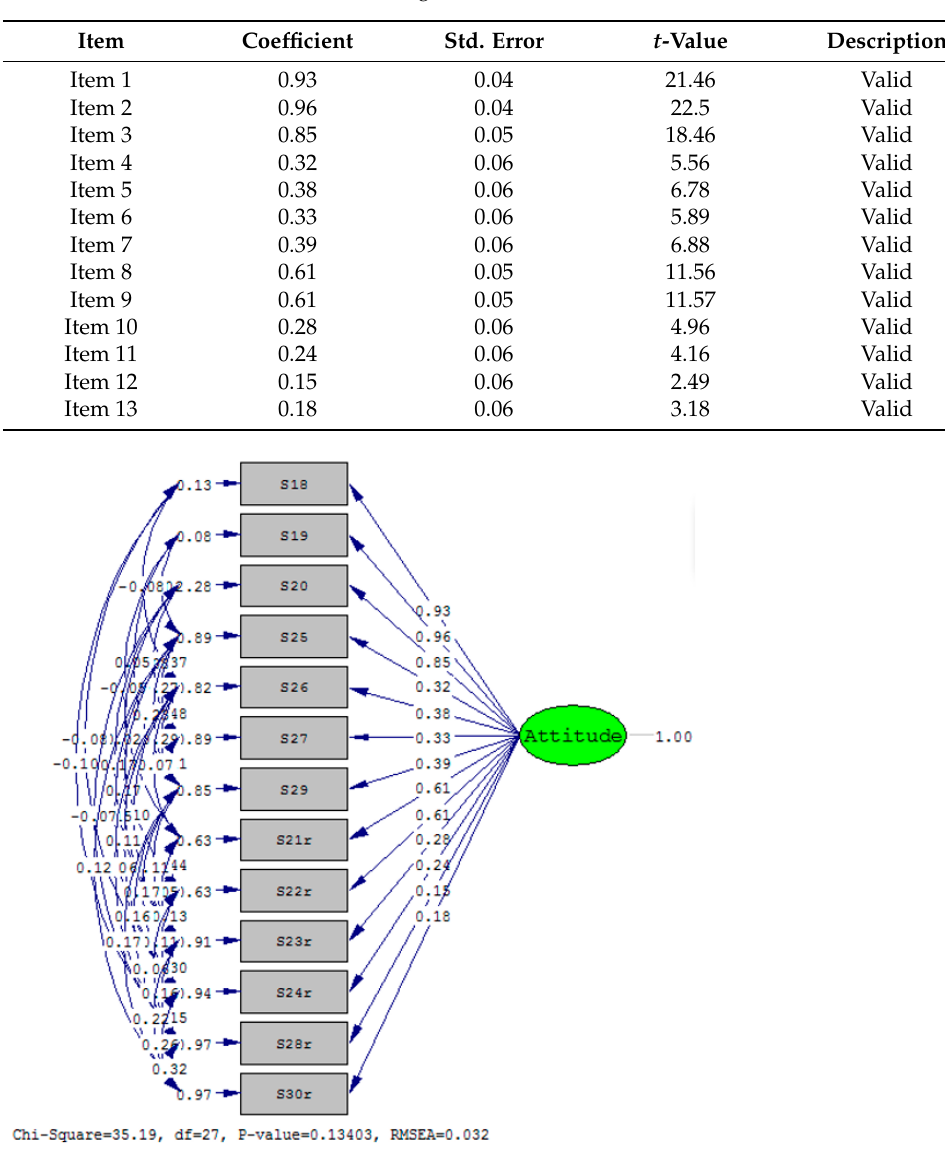
Figure 2. Diagram of CFA of the Islamic Religious Moderation Attitudes Scale.